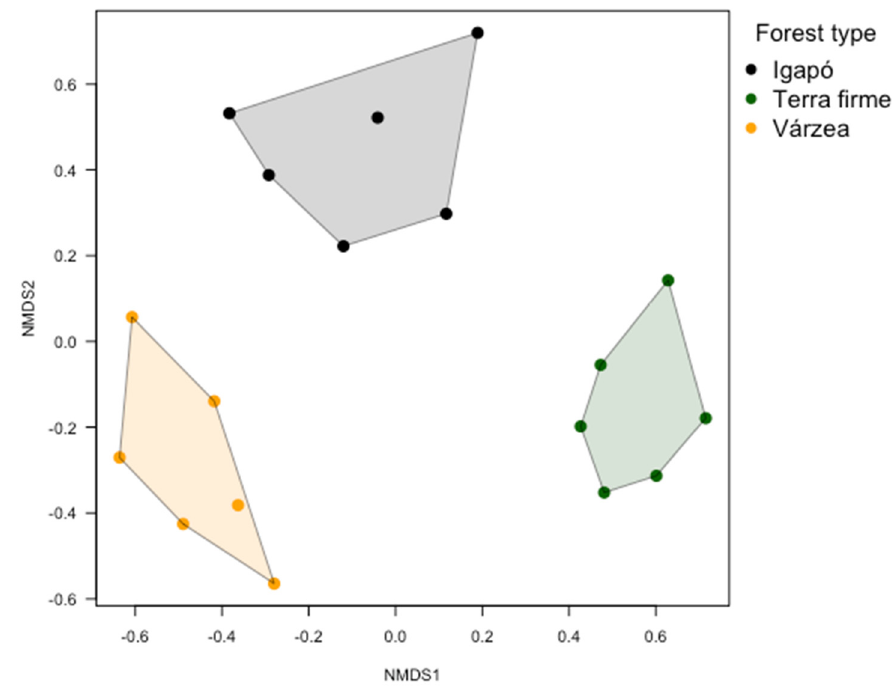
Figure 4. NMDS ordination of the butterfly assemblages in terra firme , várzea, and igapó at Uauaçu Lake, central Amazonia, Brazil. Green circles are terra firme , orange circles are várzea, and grey circles are igapó sample units. Table 1. Butterfly indicator species for the three forest types at Uauaçu Lake, central Amazonia, Brazil. Records = species abundance and number of sample units in which the species was sampled (in parenthesis). Stat = the percentage of the IndVal combination of “A” (specificity) and “B” (fidelity). p = probability of the indicator value.